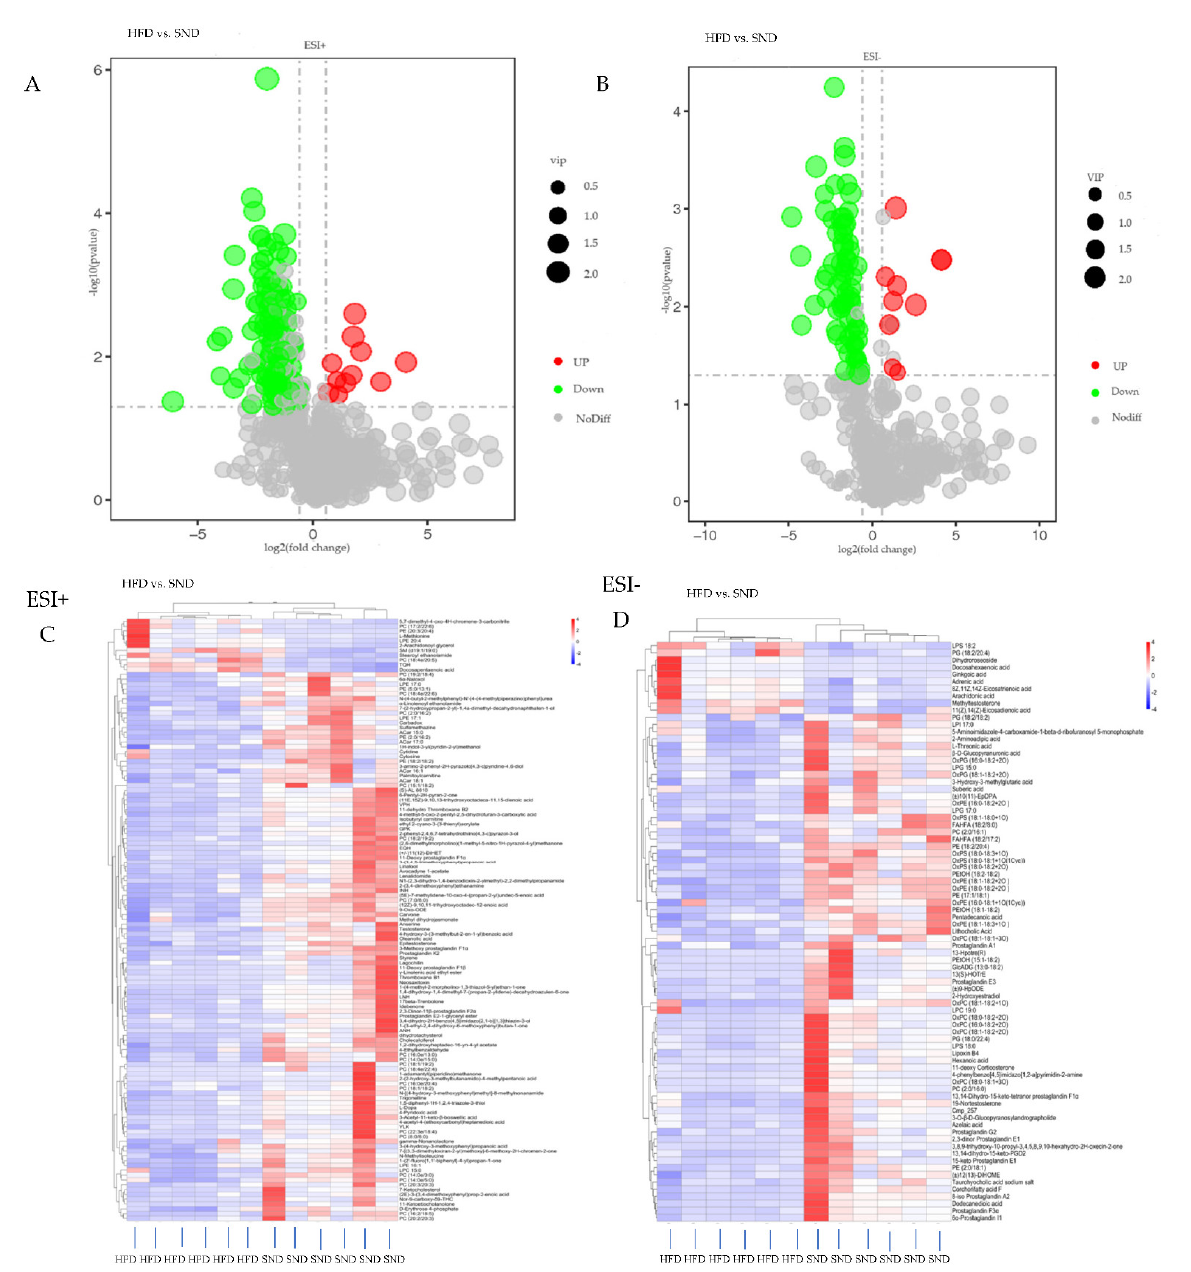
Figure 3. Differential metabolites analysis. Volcano maps showing the overall distribution of differential metabolites in rabbit groups fed SND ( n = 6) and HFD ( n = 6) in the positive ( A ) and negative ( B ) ion modes. Red circles represent significantly higher numbers of metabolites, and green circles indicate significantly lower numbers of metabolites in HFD ( n = 6) than in SND ( n = 6) rabbit groups. Heat map representing a hierarchical clustering of positive ( C ) and negative ( D ) ion mode of differential metabolites between HFD and SND. Shades of red and blue represent an increase or reduction of a metabolite, respectively, relative to median metabolite levels (see color scale). A = HFD, a = SND.